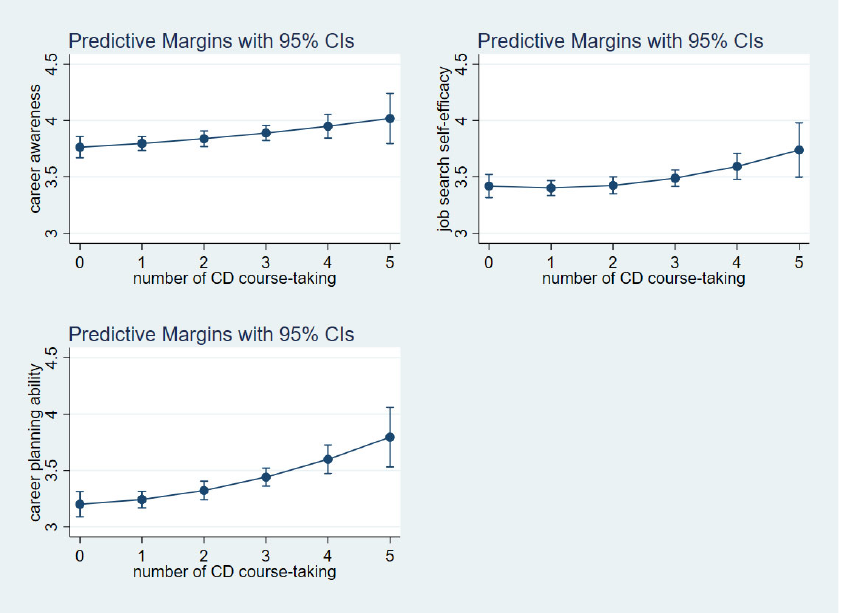
Figure 2. Predictive margins of career awareness, job search self ‐ efficacy, and career planning ability with quadratic terms by the number of career development courses taken.